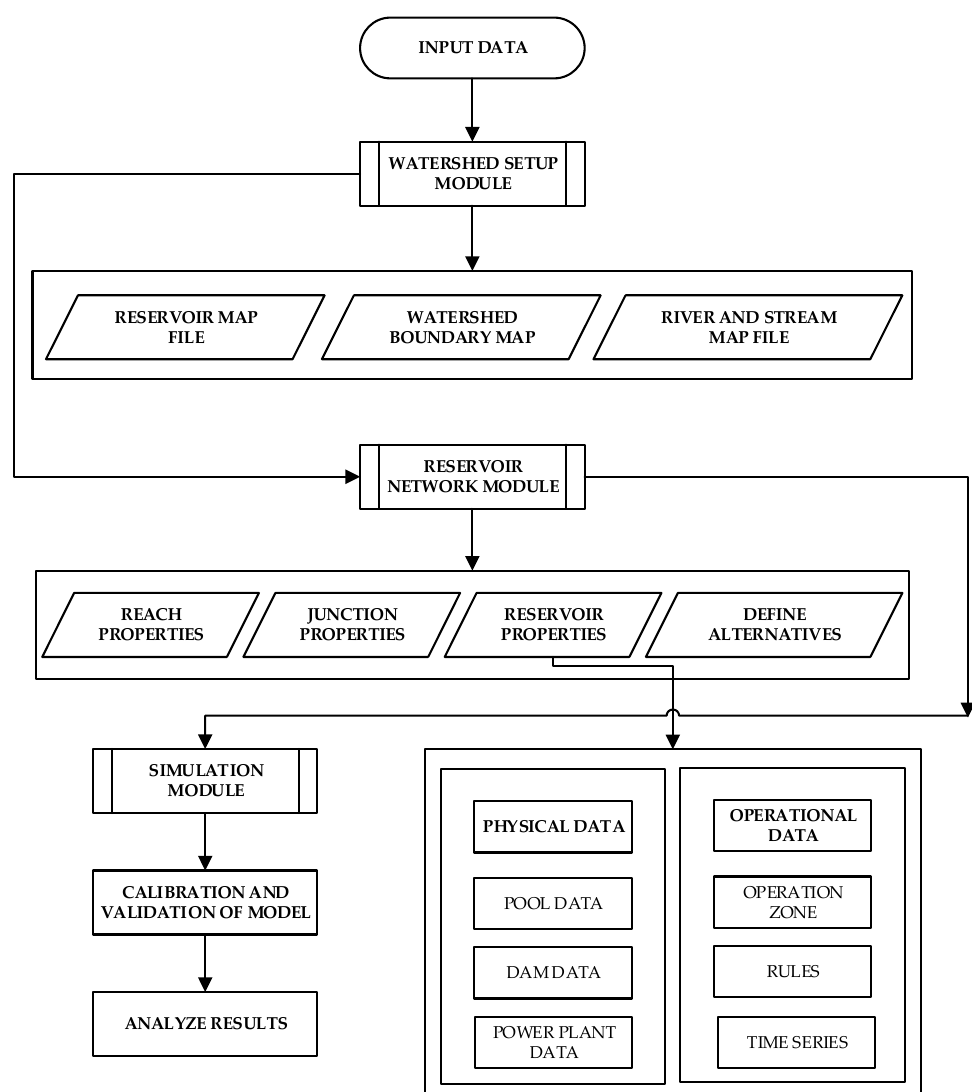
Figure 3. Flow chart for the HEC-ResSim Simulation.